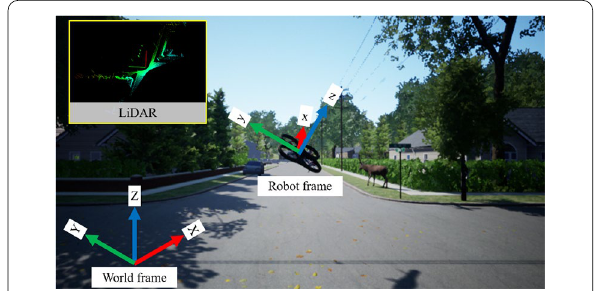
Fig. 1 Screenshot of AirSim with coordinate description. An IMU and a LiDAR are equipped to the drone in the simulator. The purpose of the proposed DNN is estimating a gravity vector in the robot frame from LiDAR